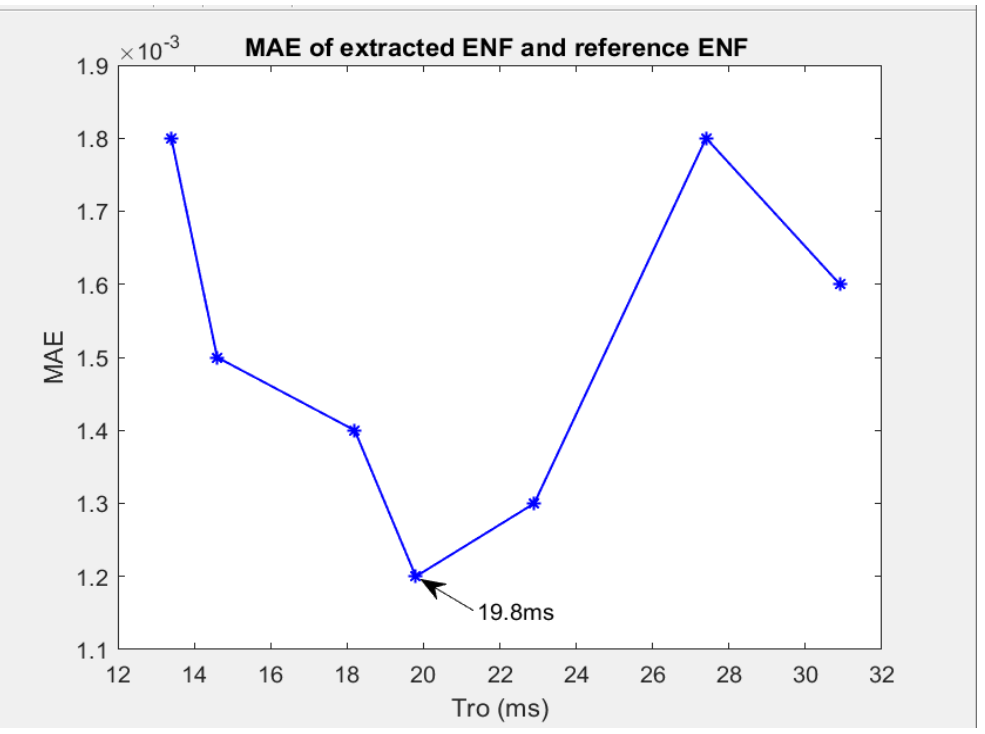
Figure 10. MAE of the extracted ENF and the reference ENF.